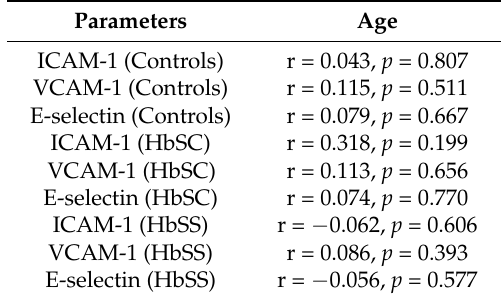
Table 5. Correlation between levels of soluble adhesion molecules and age among the study participants.